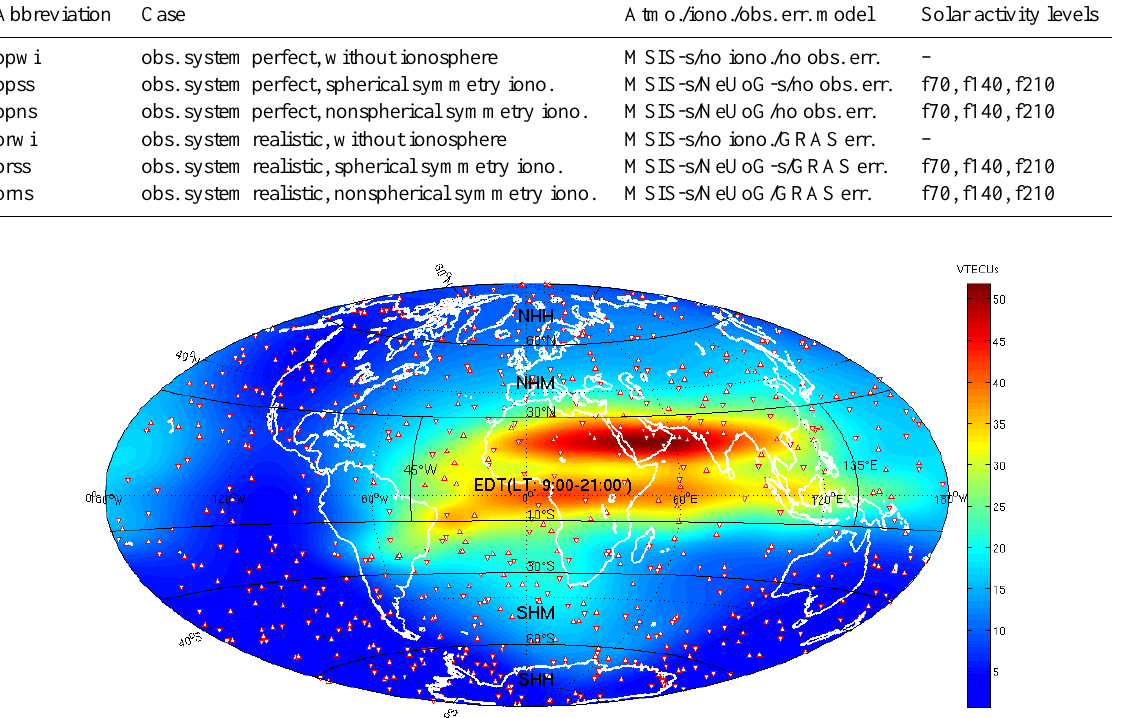
Figure 3. Distribution of the 697 RO events used in the statistical analysis: the upward-pointing triangles denote rising events, and the downward-pointing triangles denote setting events; the five latitudinal zones (NHH, NHM, SHM, SHH, EDT; Table 1) are divided by latitude-circle lines (solid lines); in the EDT region, although all the RO events during the day and night are shown here, only those RO events occurring during the local daytime (LT) 09:00–21:00 belong to the region. The background color map illustrates the ionospheric VTEC (1 VTEC unit = 10 16 electronsm − 2 ) at 12:00UTC on 15 July 2008 under the medium solar activity level (F10.7 =